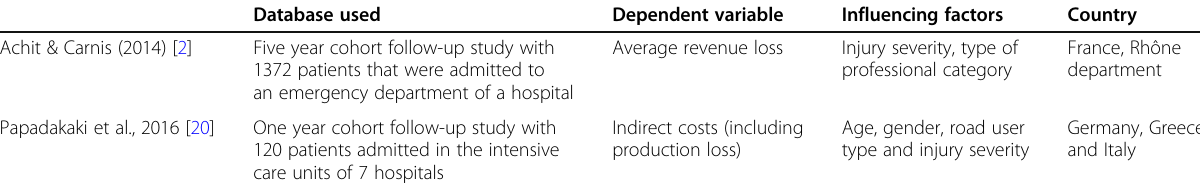
Table 4 Description of the studies that provide more detailed analyses on medical